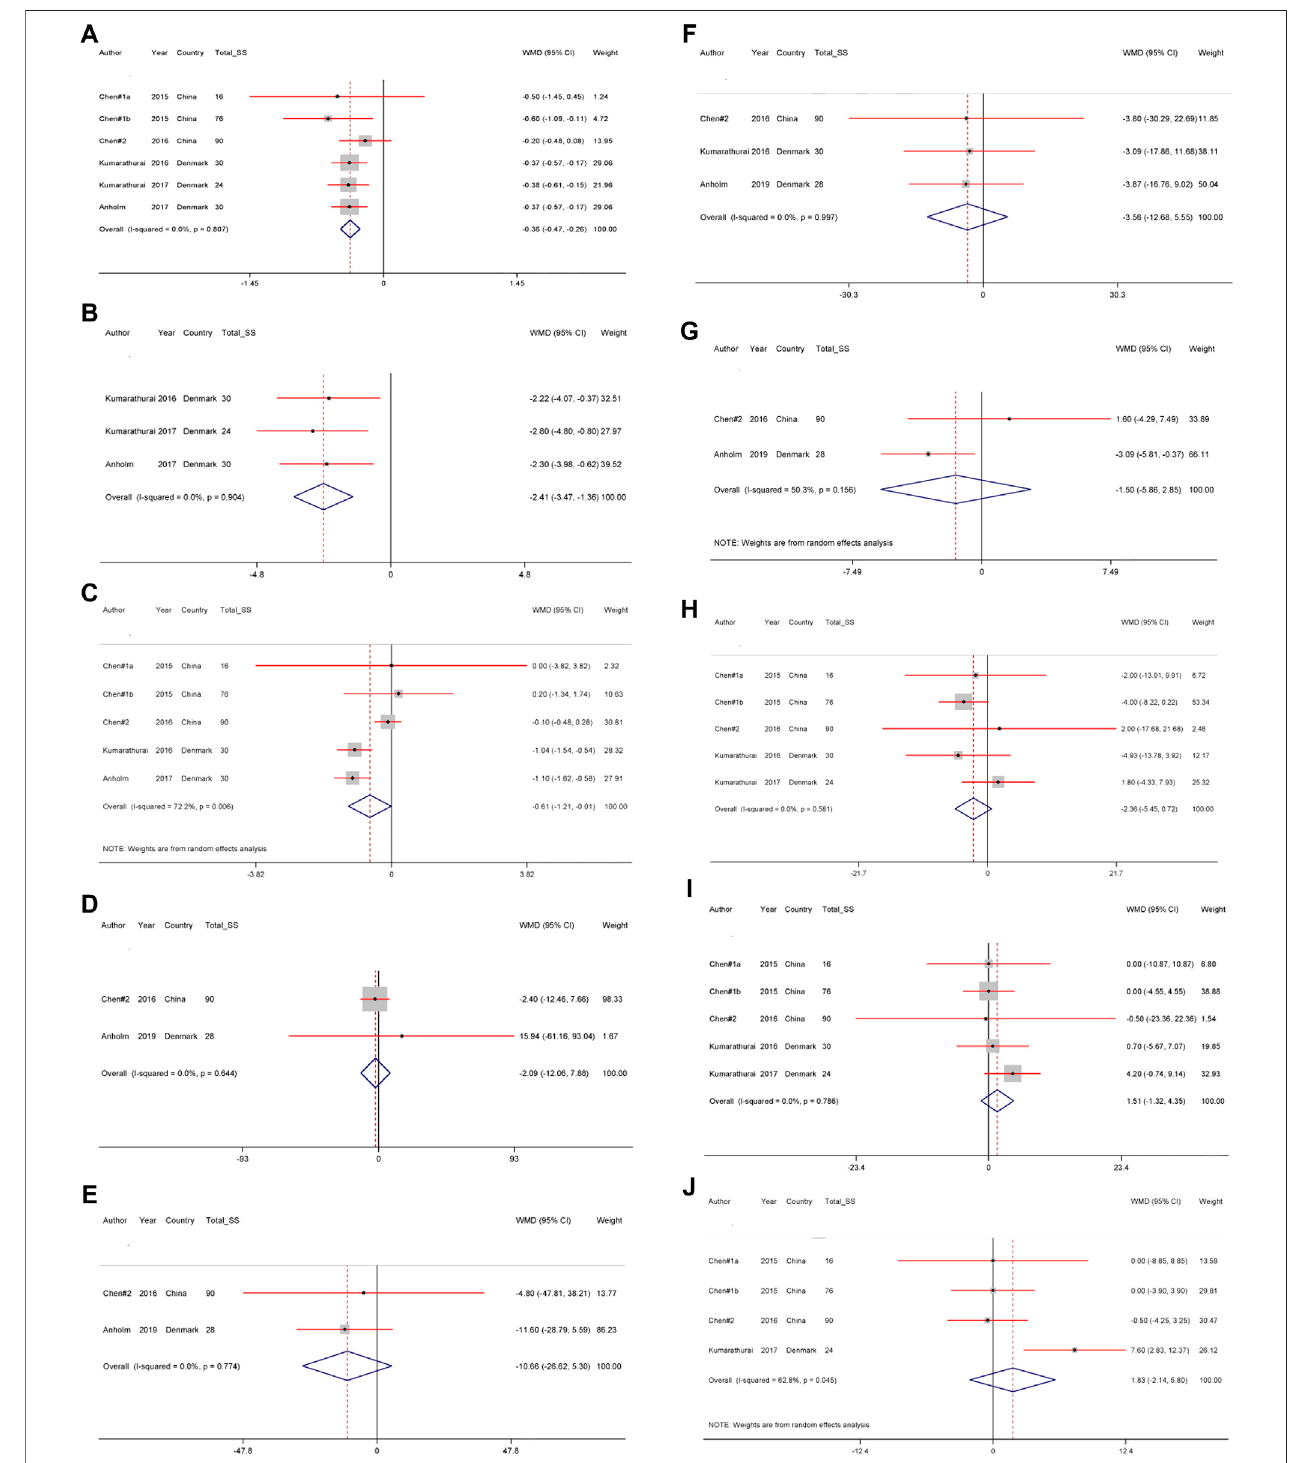
FIGURE3| A) – (J) Theeffectofliraglutide useon (A) hemoglobin A1c, (B) body massindex (C) waist circumference, (D) triglycerides (E) total-cholesterol, (F) low- density lipoprotein – cholesterol (G) high-density lipoprotein – cholesterol, (H) systolic blood pressure, (I) diastolic blood pressure and (J) Heart rate levels.